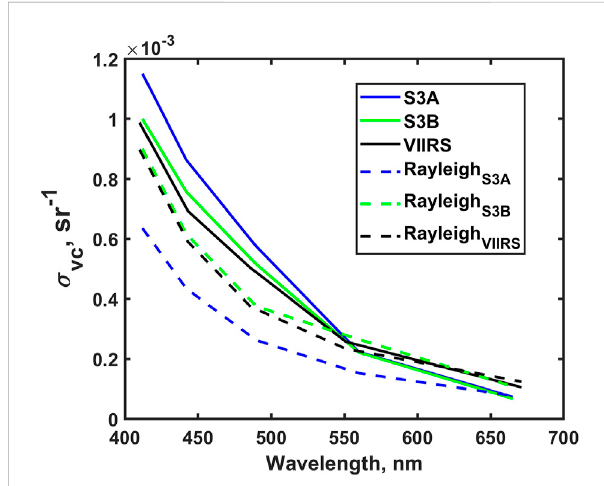
FIGURE 10 Standard deviations during system vicarious calibration for OLCI and VIIRS σ vc compared with Rayleigh component spectra for these sensors at the MOBY